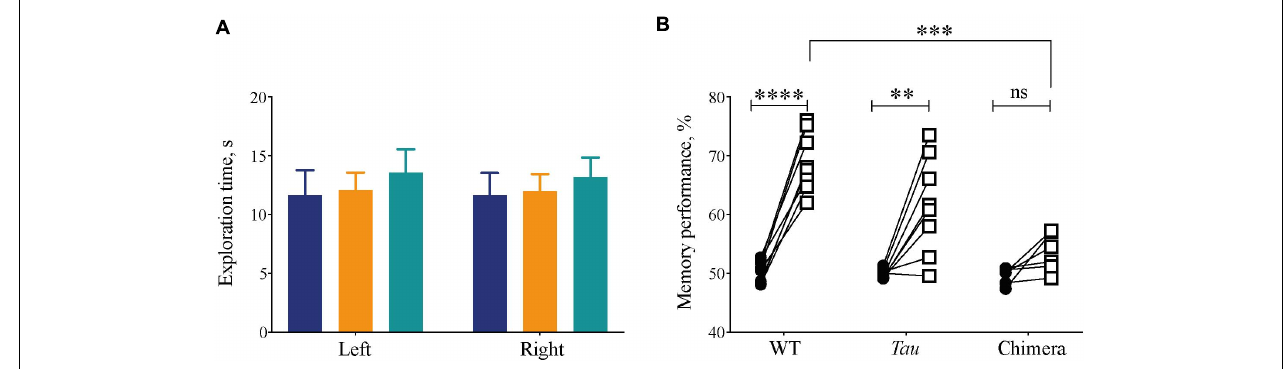
FIGURE 6 | Compromised recognition memory performance in circadian chimeric mice. (A) The amount of exploration time (mean ± SEM) mice spent on the objects during the training session (identical objects) was not significantly different between groups (WT (blue), Tau control (orange), and chimeric (green) mice). (B) The percentage time (mean ± SEM) the mice spent on the novel object (open squares) was significantly greater than during the training phase (closed circles) in the WT and Tau mice, whereas chimeric mice performed poorly on the test phase (two-tailed paired Student’s t -test within genotype, ∗∗ p < 0.01, ∗∗∗∗ p < 0.0001; 2x ANOVA between genotypes; post hoc Tukey’s multiple comparisons test ∗∗∗ p < 0.001 WT vs.